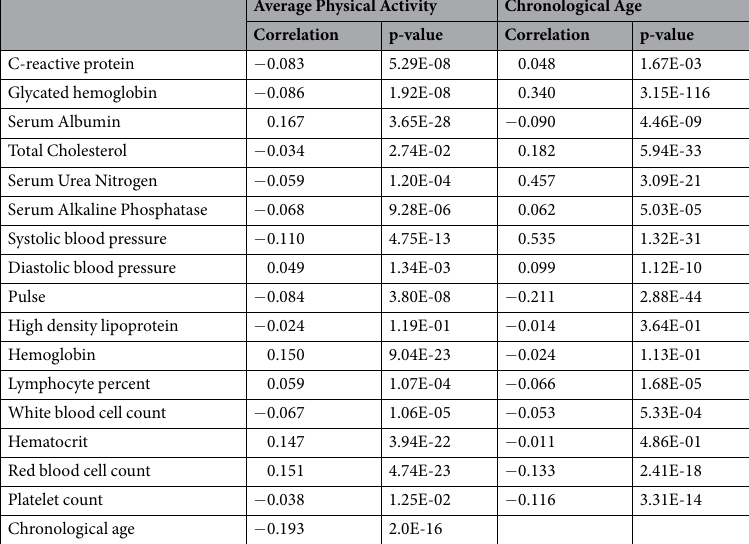
Table 2. Correlation between average physical activity, chronological age, and blood biomarkers.